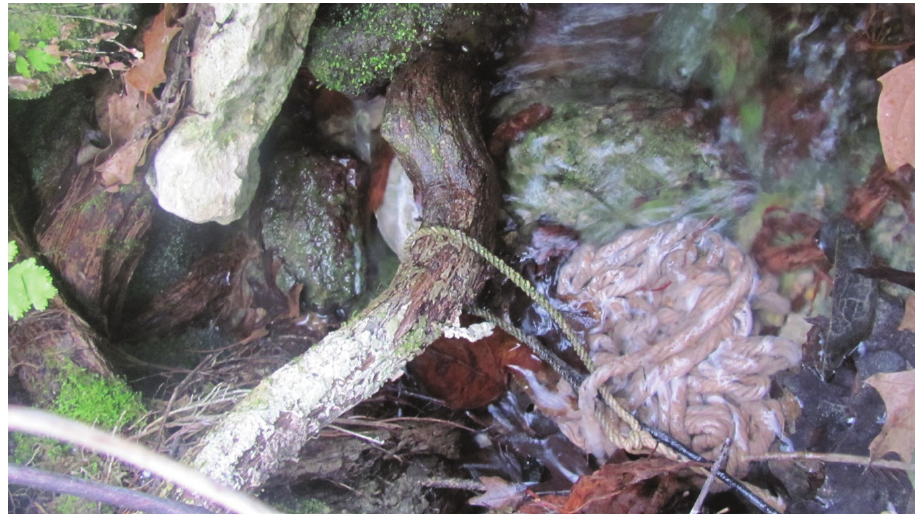
Figure 2. Mophead in spring outlet at Cold Spring, Travis County, Texas, USA. to December 2011 and then again 22 times between 21 October 2016 and 30 March 2018, for a total of over 1,000 days of trapping effort. Specimens are deposited in the Biodiversity Collections of the University of Texas at Austin and at the San Marcos Aquatic Resources Center, United States Fish and Wildlife Service (Table